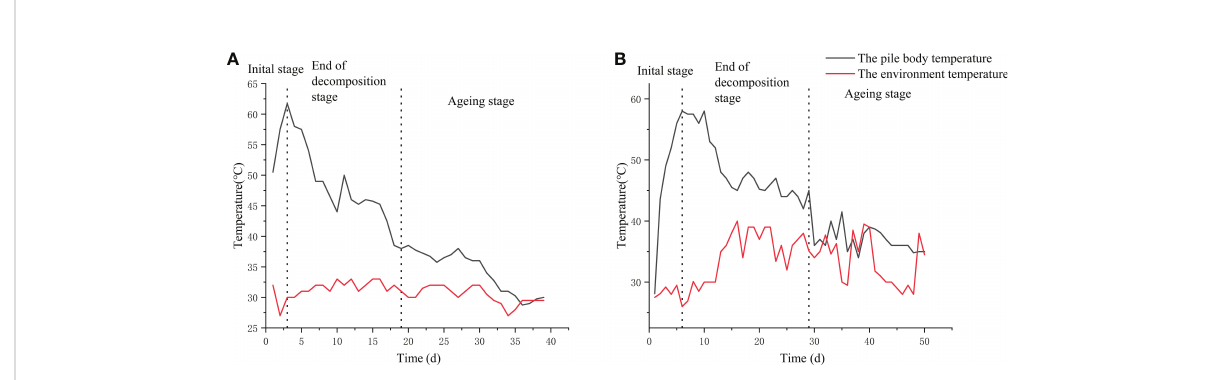
FIGURE 1 Changes in the temperature curve between ends of decomposition: (A) Frame composting; (B) Natural